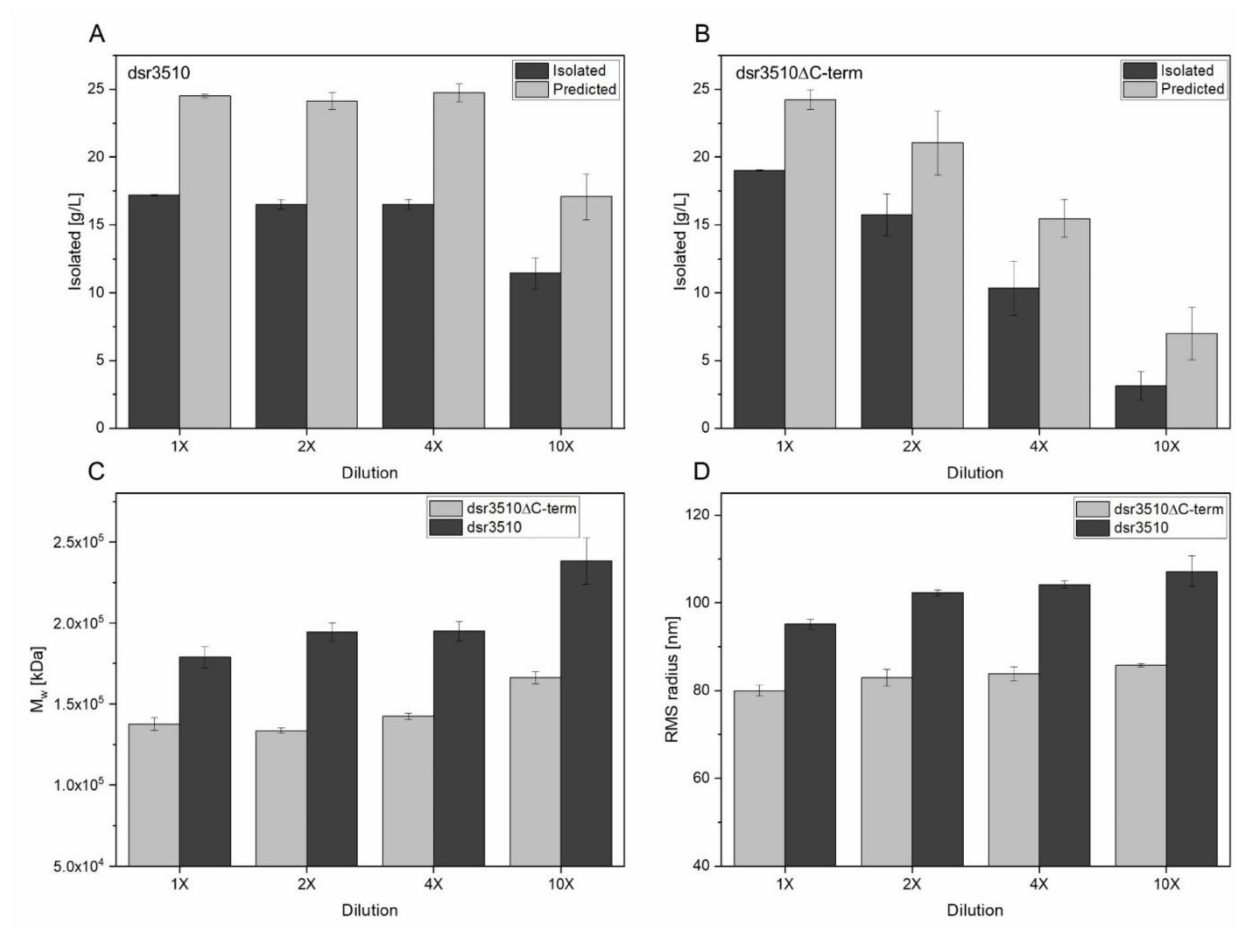
Figure 3. Isolated and predicted (=calculated on the basis of transglycosylation rates) amounts of dextrans produced by heterologously expressed variants dsr3510 ( A ) and dsr3510 ∆ C-term ( B ) for 24 h at 30 ◦ C and pH 5.0, applying different enzyme concentrations. Particle sizes of the formed dextrans were determined by AF4-MALS-UV measurements with regard to their average molecular weights (M w , ( C )) and root-mean-square (RMS) radii ( D ). Values are given ±